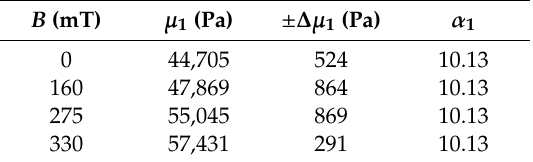
Table 1. The fitted model parameters under di ff erent magnetic flux